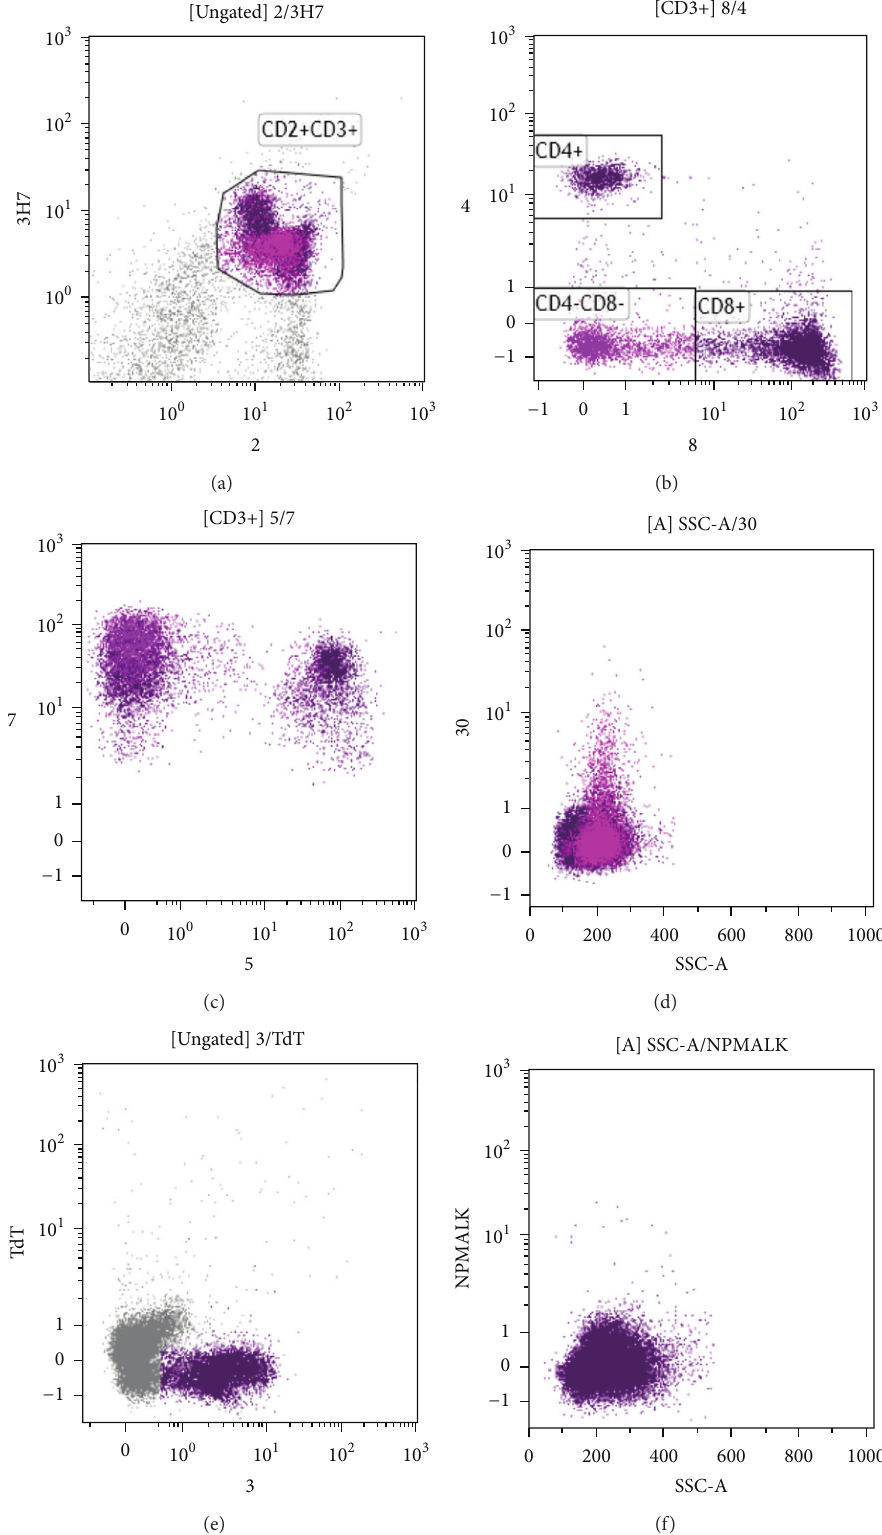
Figure 2: Flow cytometry of the peripheral blood showing T cells (coloured purple) identified by CD2/CD3 coexpression (a) subcategorised based on CD4 and CD8 expression with the CD4/CD8 “double-negative cells” coloured pink (b) showing CD7 and CD5 expression (c), CD30 expression (d), TdT (e) and NPM-ALK (f). Images compiled using Kaluza Flow Analysis software v1.2 from Beckman Coulter